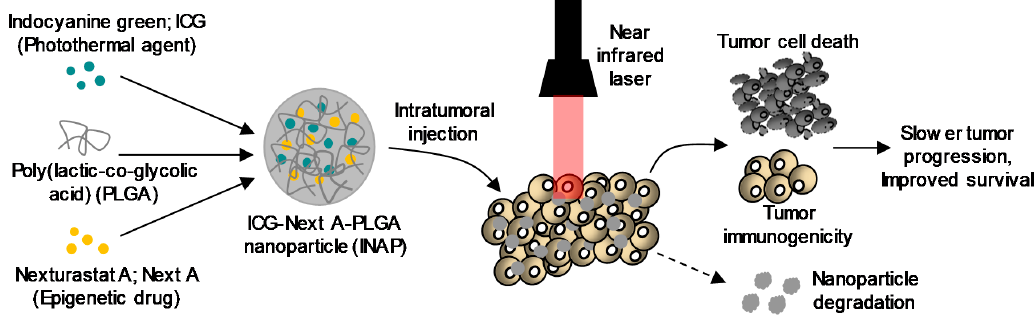
Figure 1. Hypothesized mechanism of action of our approach combining photothermal and epigenetic therapy for melanoma using poly (lactic- co -glycolic acid) (PLGA) nanoparticles. The photothermal agent, indocyanine green (ICG), and the epigenetic drug, Nexturastat A (NextA), were co-encapsulated within PLGA nanoparticles (ICG-Next A-PLGA; INAPs). The INAPs were administered to melanoma tumors in syngeneic murine models and activated with an 808 nm near infrared laser. ICG-based photothermal therapy along with concurrent epigenetic drug (NextA) release in the tumor microenvironment causes tumor cell death and increased immunogenicity, which we expected to slow tumor growth and improve survival in melanoma when compared to either therapy alone. Further, since PLGA is biodegradable, we expected our INAP platform to mitigate toxicity concerns associated with the long-term persistence of nanoparticles in